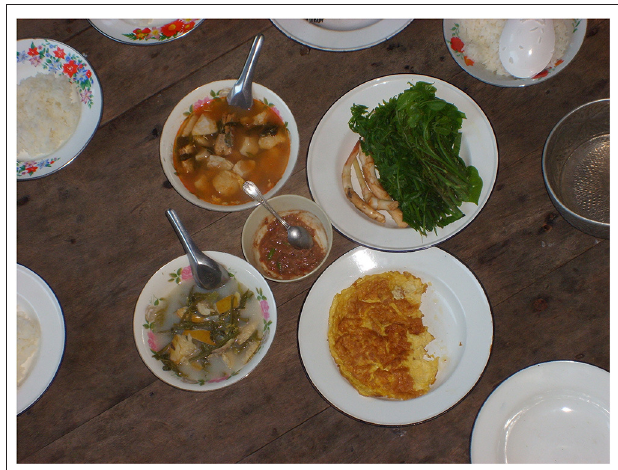
FIGURE 6 | Typical traditional Karen